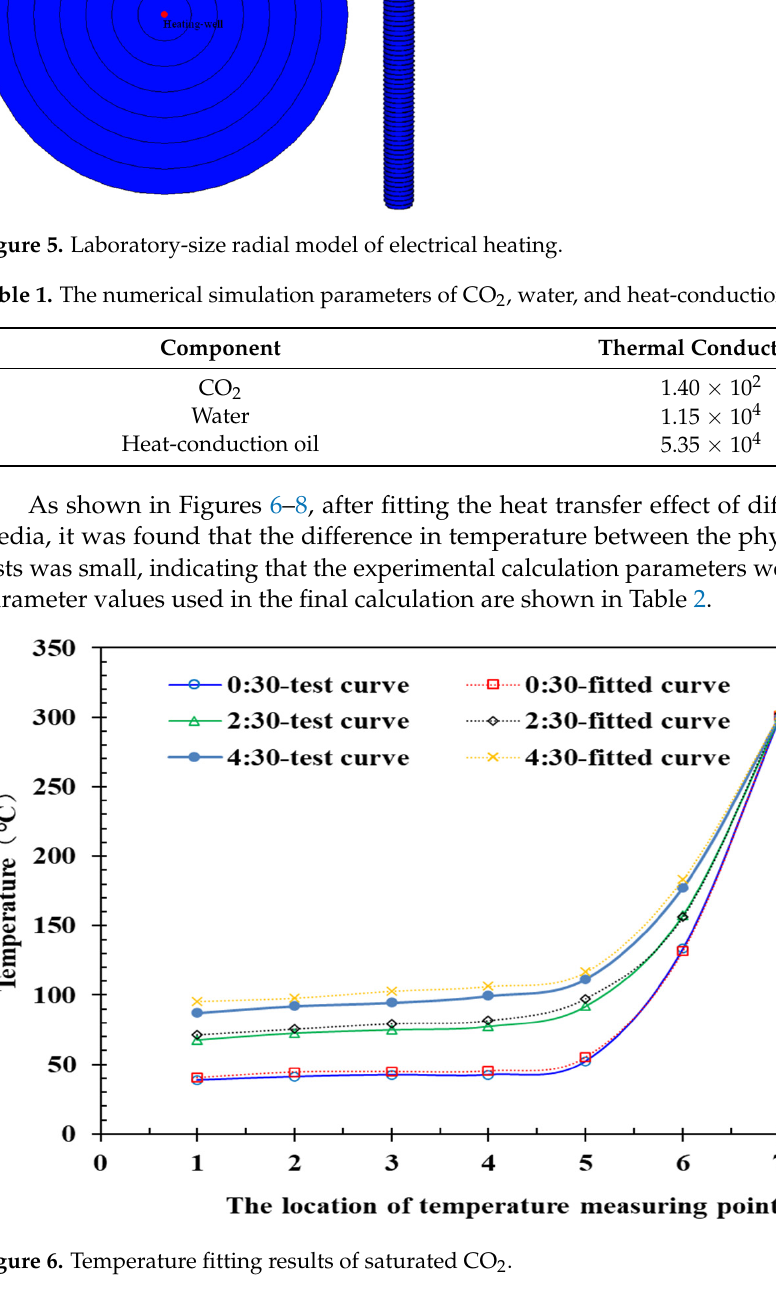
Figure 7. Temperature fitting results of water.